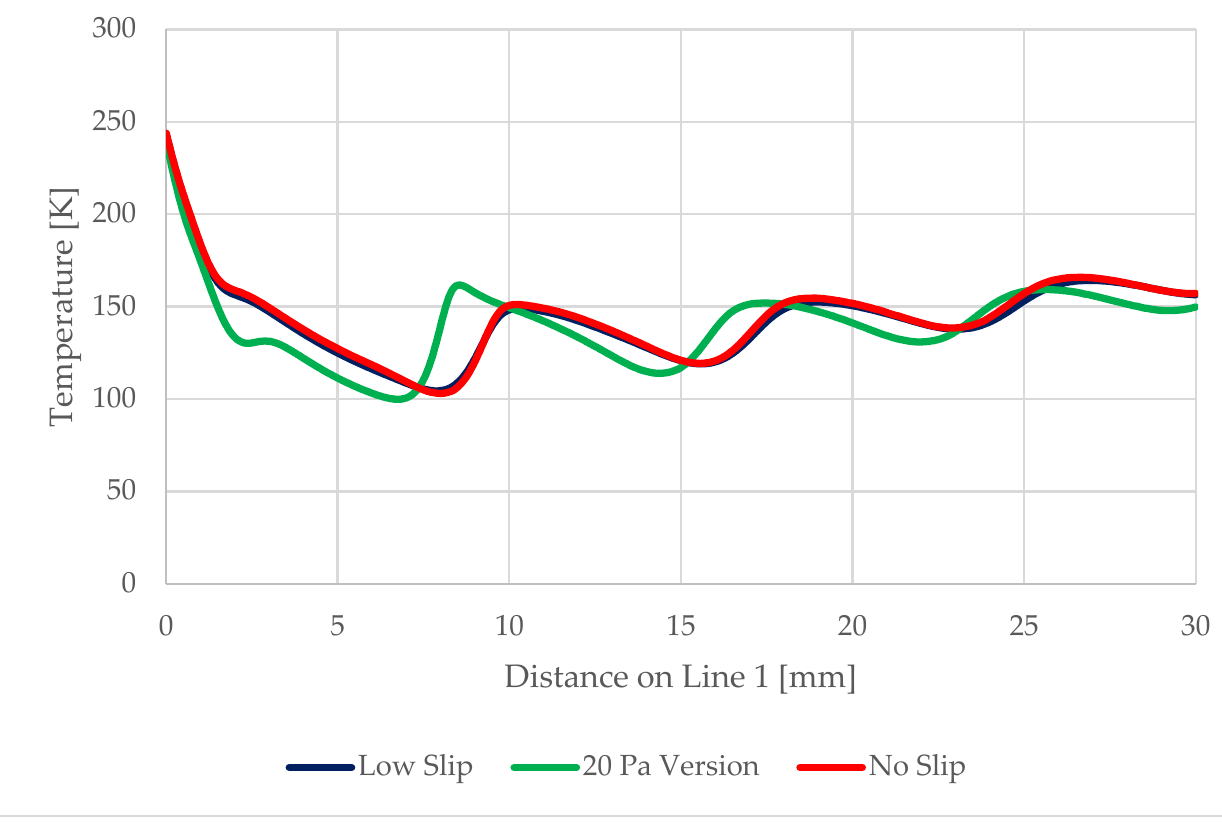
Figure 23. Static temperature distribution for the variants studied. Since we are considering pressure values and steep gradients in an extreme environ- ment, it is a good idea to evaluate the speed of sound in that environment. The speed of sound at Line 1 is shown in Figure 24 and its distribution is in Figure 25.